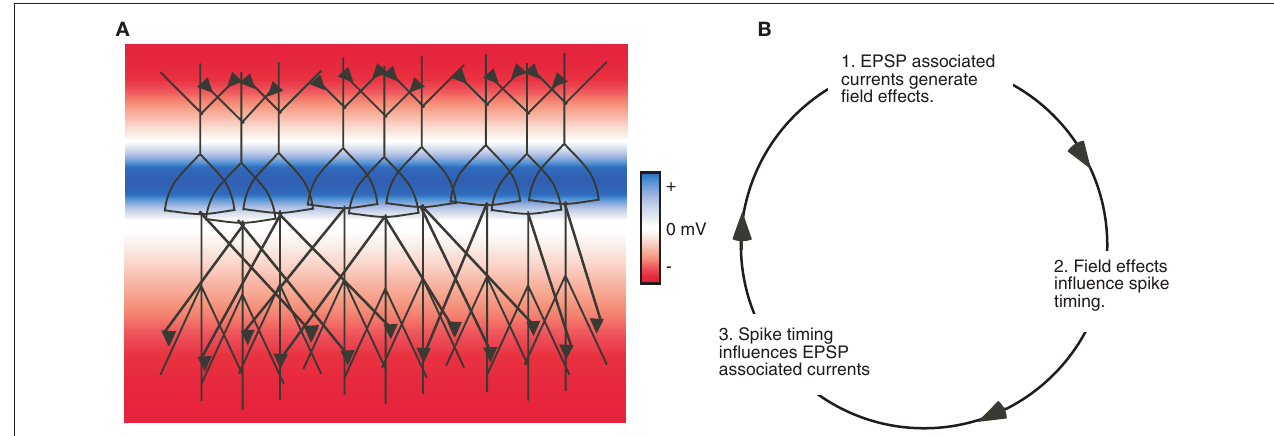
Figure 5 | Field effects can be amplified by network interactions involving chemical synapses. (A) An illustration of pyramidal neurons arranged in a parallel laminar orientation interconnected by excitatory chemical synapses on the apical and basal dendrites. Colors indicate the extracellular potential resulting